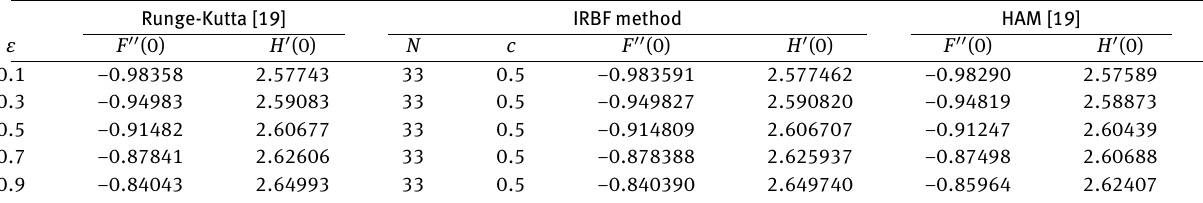
Table 6: Comparison between indirect RBFs and other solutions of F (cid:48)(cid:48) (0) and H (cid:48) (0) for some ε at β = 6 and ϕ = 0